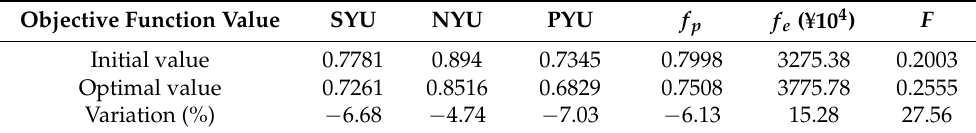
Table 3. Initial, optimal value, and variation of each objective